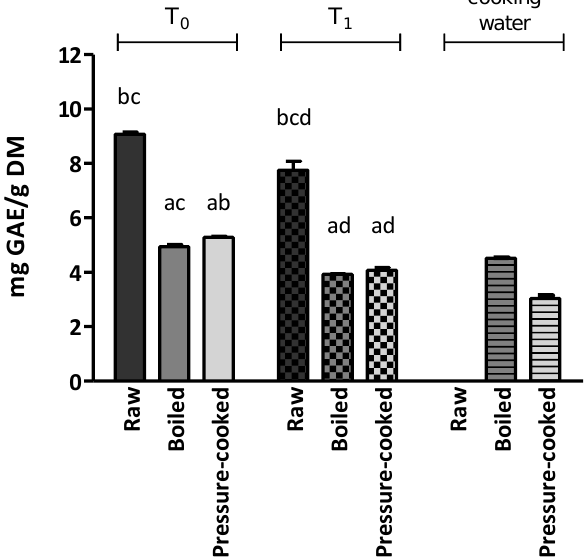
Figure 1. Total phenolic content of Lenticchia di Castelluccio di Norcia PGI at T 0 , T 1 and its cooking water. The results are expressed as the mean ± standard error of the mean. Statistical significance: p < 0.05. a vs. raw; b vs. boiled; c vs. pressure-cooked; d vs. T 0 .